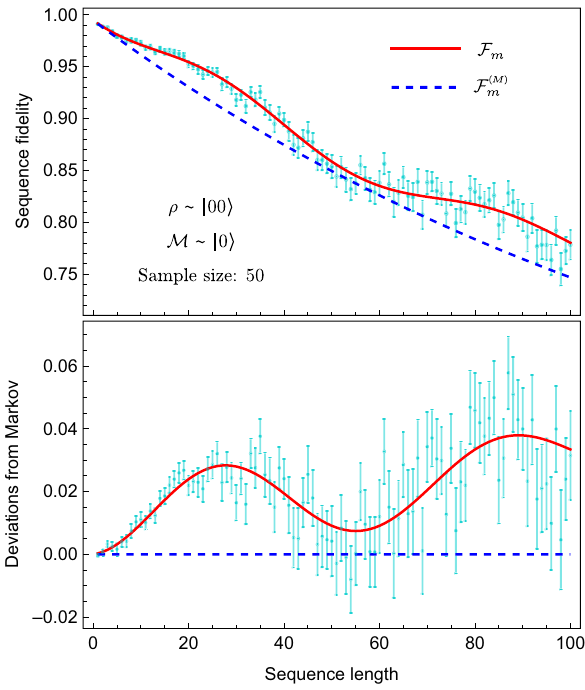
FIG. 4. Average sequence fidelity for time-independent unitary non-Markovian noise and deviations from its Marko- vianized counterpart. We consider the noise model described by the two-spin interaction of Eq. (24) with δ ≈ 0.03, J = 1.7, h x = 1.47, and h y = − 1.05, for a single qubit as system S . We take ρ = | 00 (cid:8)(cid:9) 00 | and M = | 0 (cid:8)(cid:9) 0 | . Top: the continuous (red) line denotes the analytical ASF given by Eq. (7), with each point joined for clarity, the dots denote the numerical average of the ASF over 50 samples, with bars being the standard devi- ation of the mean (uncertainty of the numerical mean from the true mean), and the dashed (blue) line denotes the analytical ASF of the Markovianized process with time-independent noise ◦ (cid:3)(ε ⊗ · ) , here with ε = | 0 (cid:8)(cid:9) 0 | . Bottom: devia- (cid:3) ( M ) ( · ) = tr E tions of the ASF by both the analytical data (continuous red line) and numerical data produced by Eq. (7), from the Markovianized (dashed blue ASF, F ( M ) m